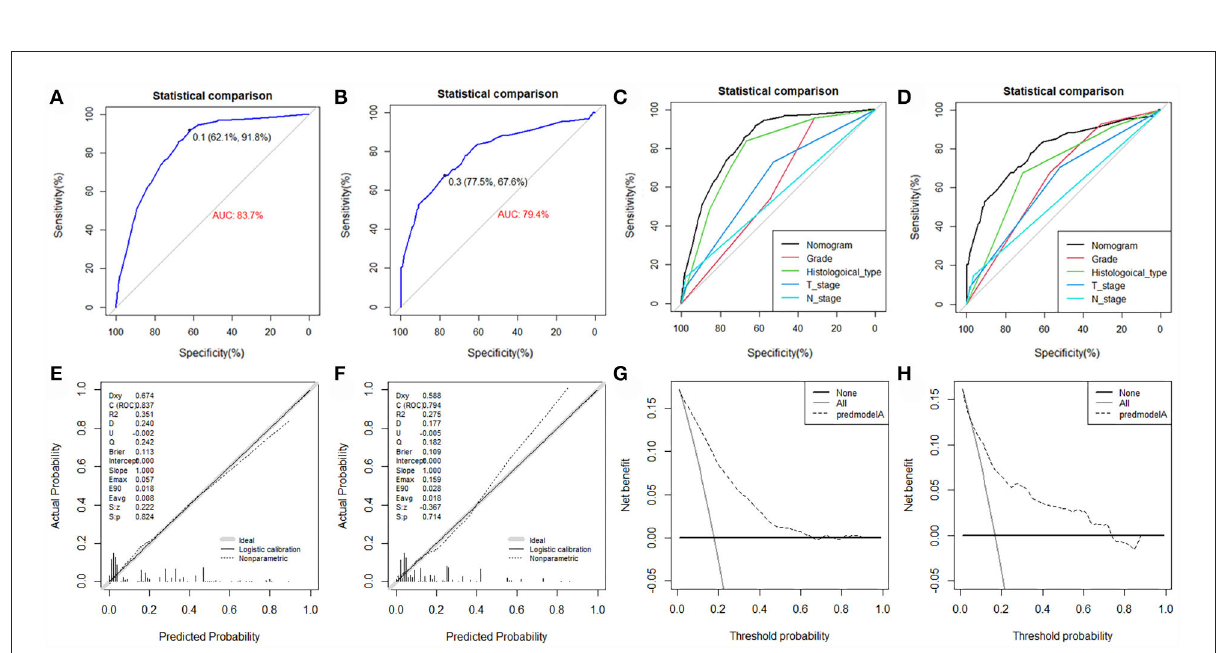
FIGURE4 ROC curve (A) , calibration curve (E) , and DCA curve (G) of the training set, and the ROC curve (B) , calibration curve (F) , and DCA curve (H) of the validation set. Comparison of AUC between nomogram and all predictors in the training set (C) and validation set (D) .